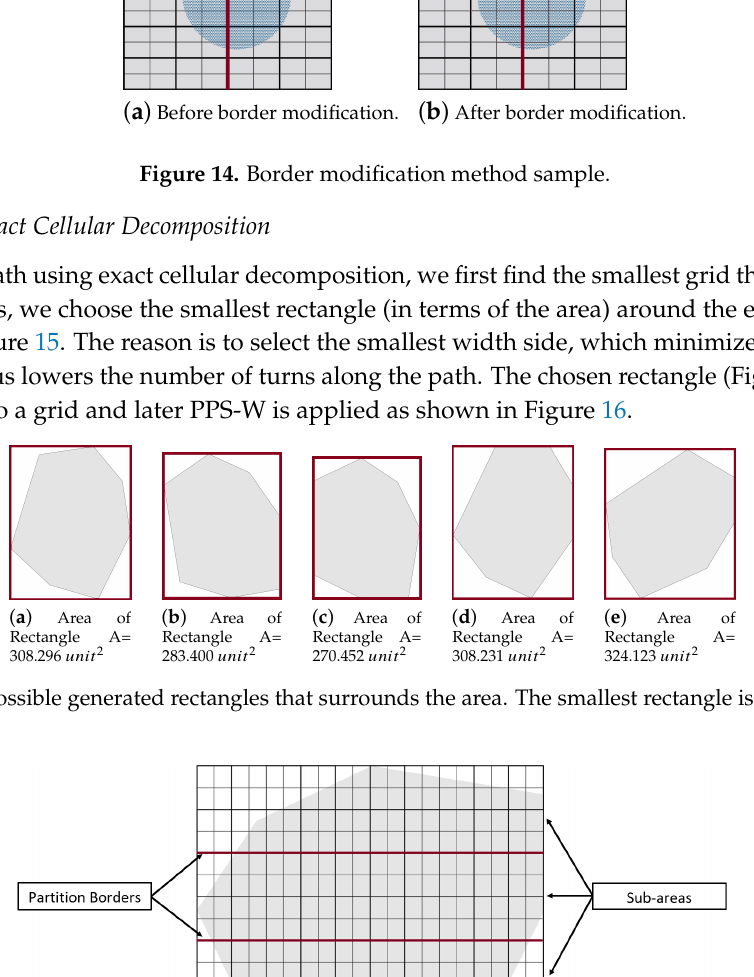
Figure 16. Area partitioned using PPS-W method.